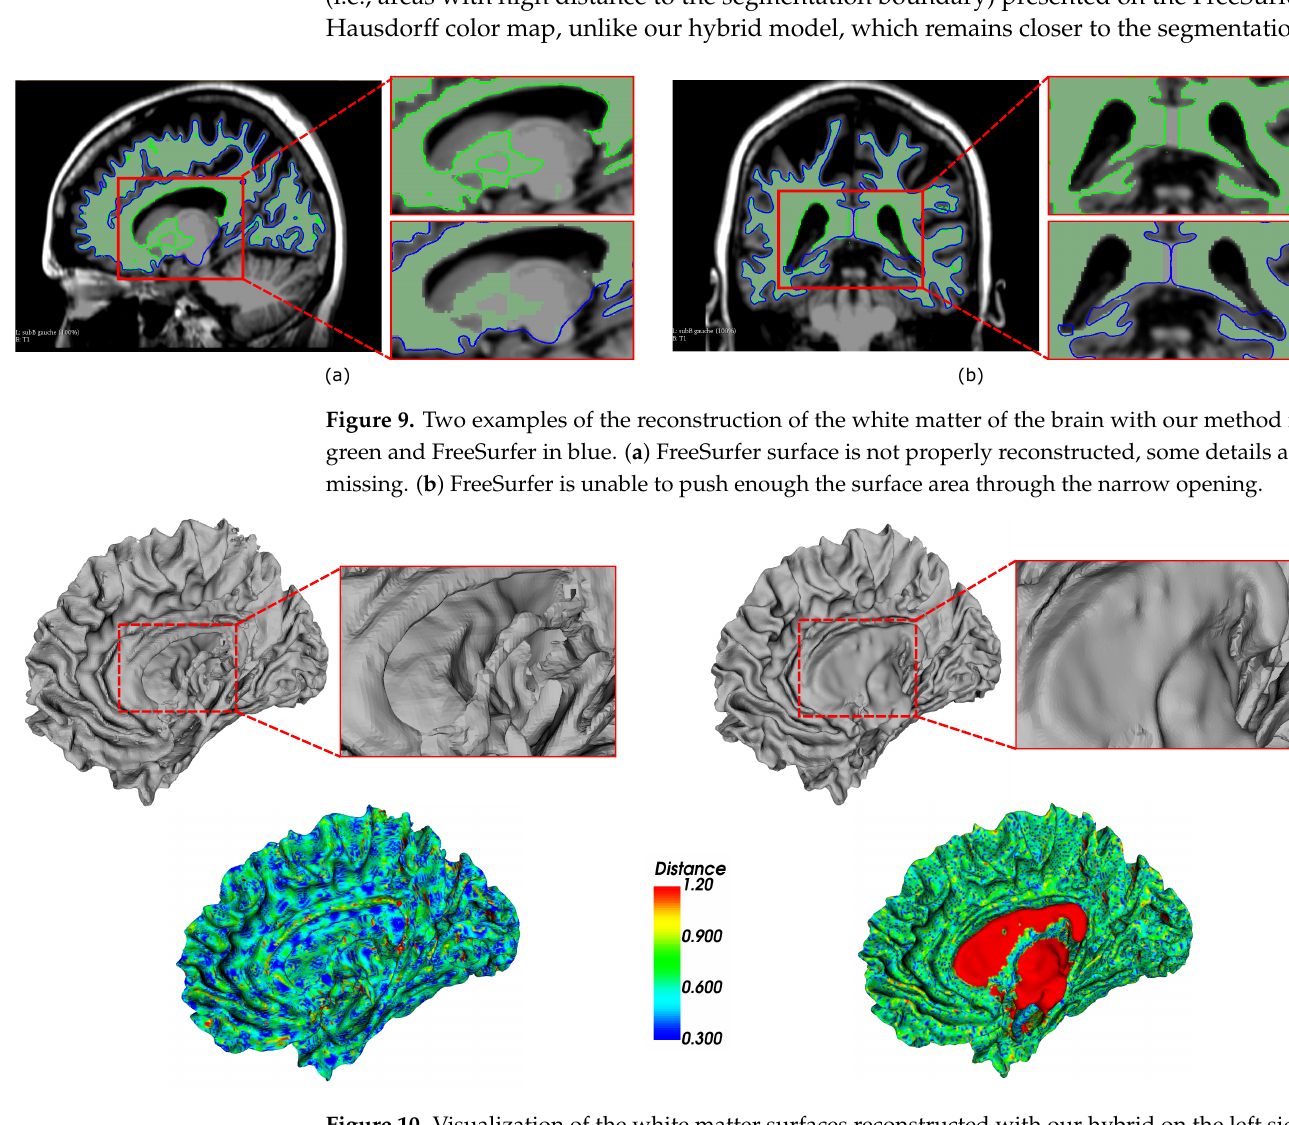
Figure 10. Visualization of the white matter surfaces reconstructed with our hybrid on the left side and FreeSurfer on the right side. For each reconstruction method, on the top, a 3D view is shown, with a zoom on the red rectangle of the reconstruction result. On the bottom, the surfaces are color- coded with the absolute distance to the segmentation from blue (small distance) to red (high distance) using the Hausdorff